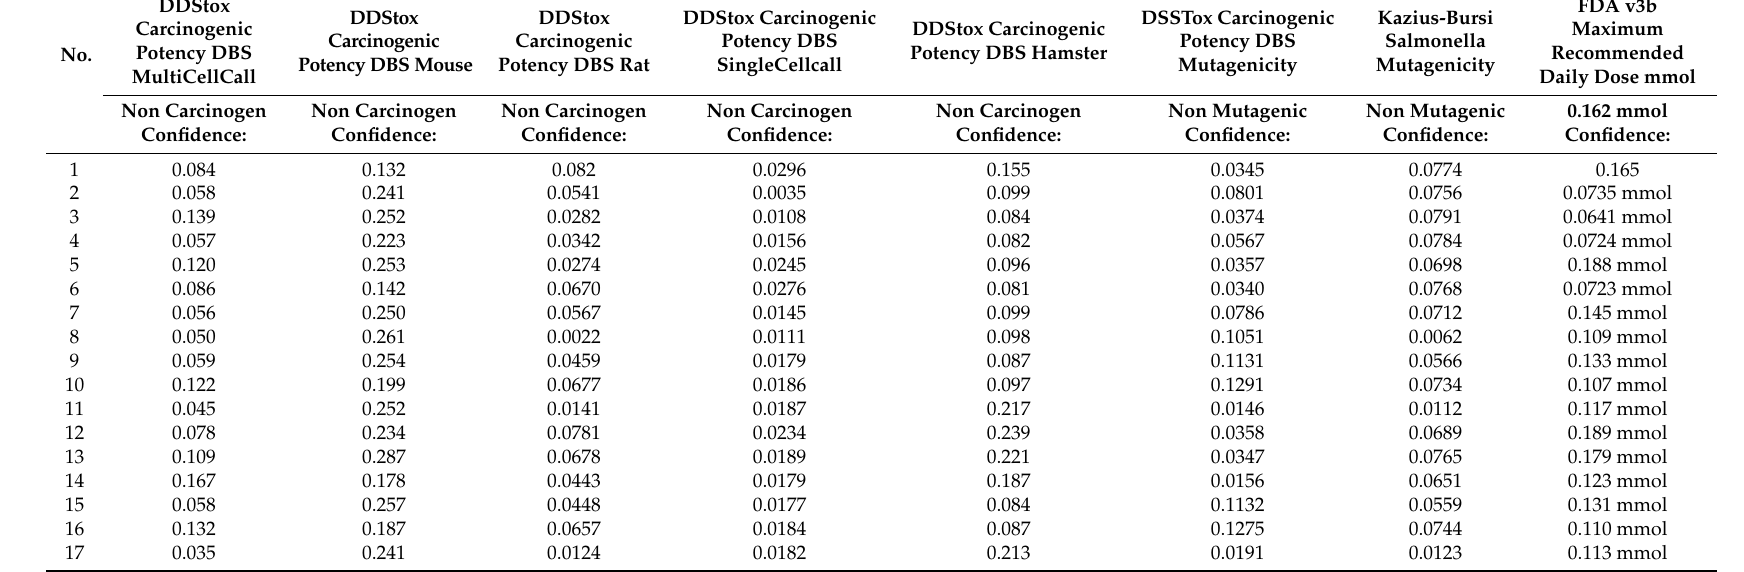
Table 3. Toxicity prediction by ToxPredict